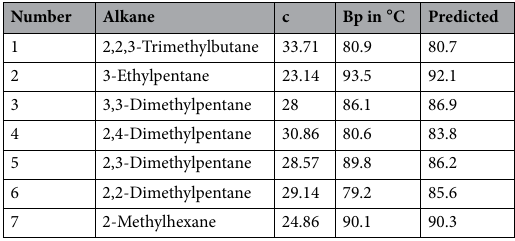
Table 8. All alkanes of order 6: Predictive ability of model (8).